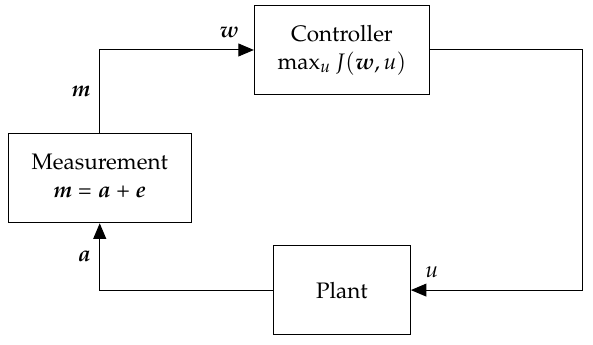
Figure 1. System Model. Please note that in this case w = m